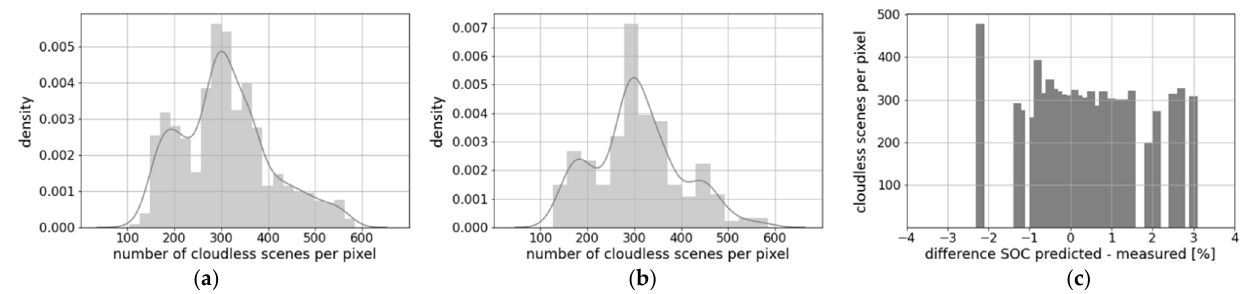
Figure 11. The distribution of the number of cloudless scenes per pixel of the calibration ( a ) and external validation ( b ) dataset. Plot ( c ) of the error in predicted (based on the external validation dataset) and measured SOC (%) as a function of cloudless scenes per pixel.